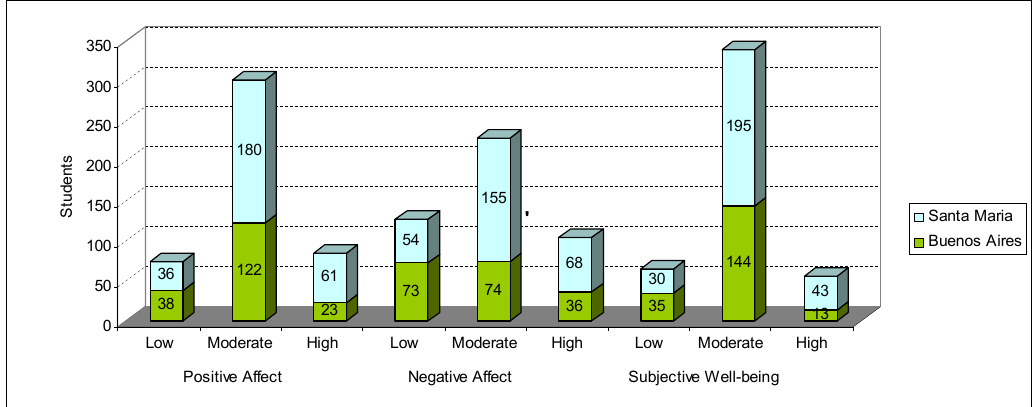
Figure 5. Scale of positive and negative a ff ection of students from Buenos Aires and Santa Maria. Source: survey data.